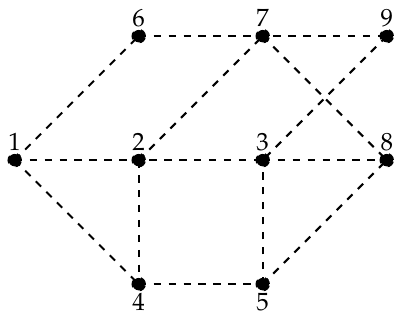
Figure 1. Possible routes of the distribution test feeder. Table 1. Lengths for the routes in Figure 1. Route Length